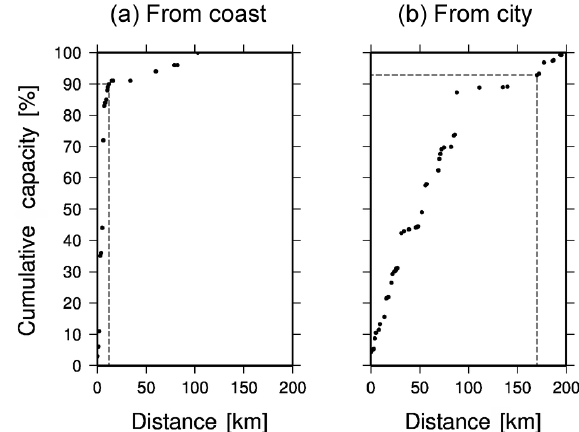
Figure 3. Cumulative capacity of desalination water and the dis- tance of plants from the coastline (a) and major cities (b) . The bro- ken line shows the 90th